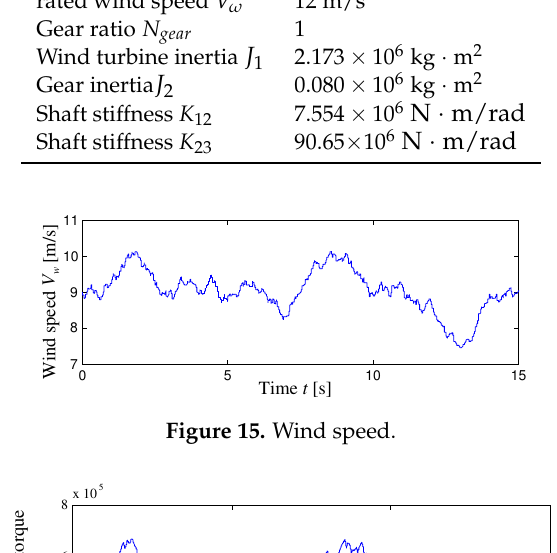
Figure 15. Wind speed.